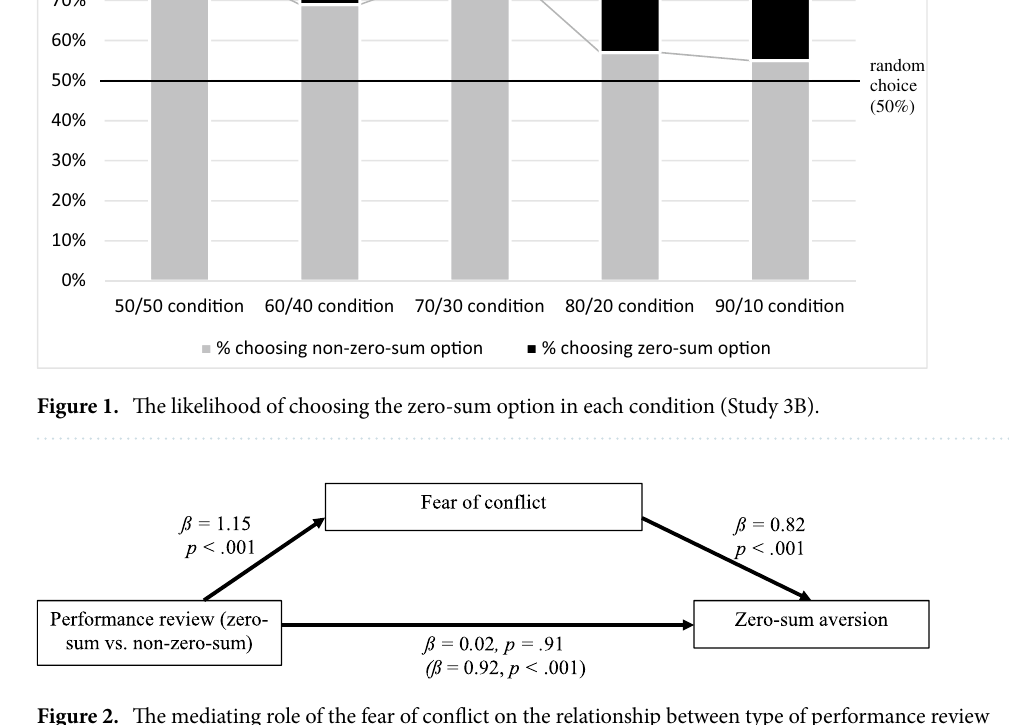
Figure 2. The mediating role of the fear of conflict on the relationship between type of performance review (zero-sum vs. non-zero-sum) and zero-sum aversion (Study